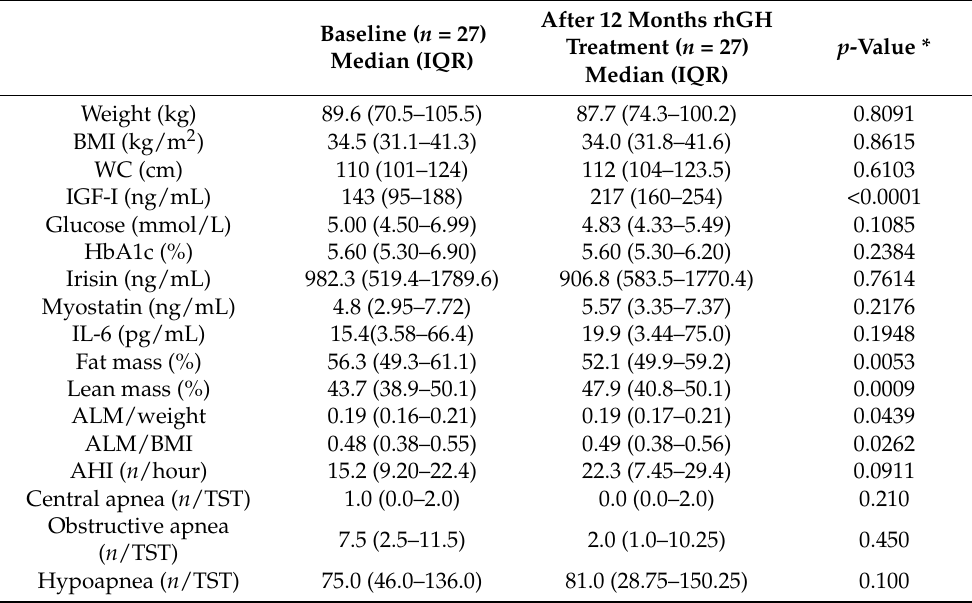
Table 2. Anthropometric, biochemical, body composition and polysomnography parameters at baseline and 12 months after the initiation of rhGH therapy in subjects with PWS.